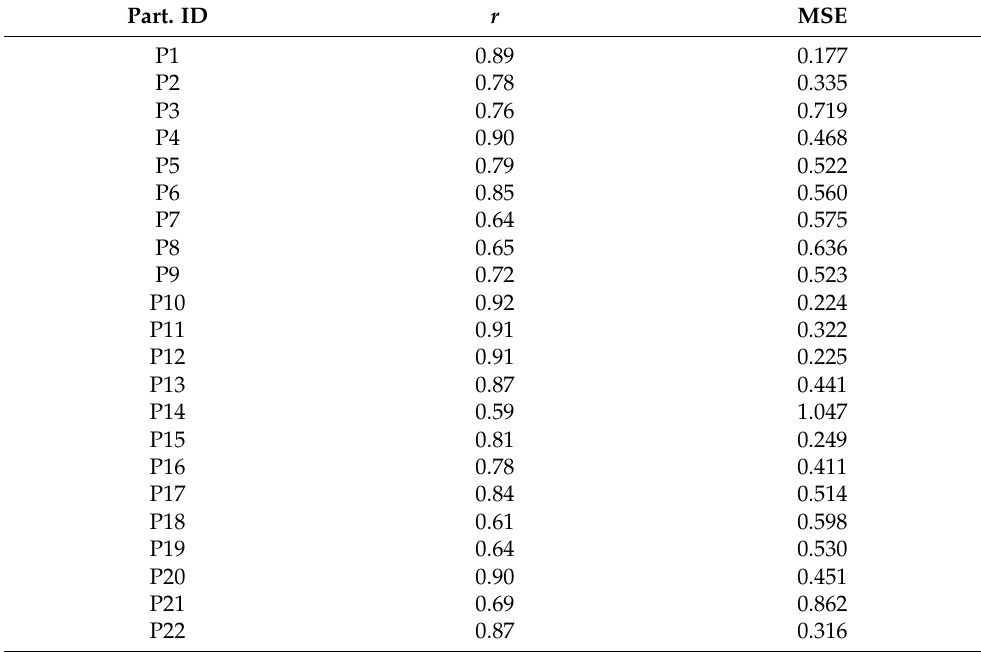
Table 2. TDNN performance indices in the second half of the signal recorded: correlation coefficient r and MSE between the predictive and observed